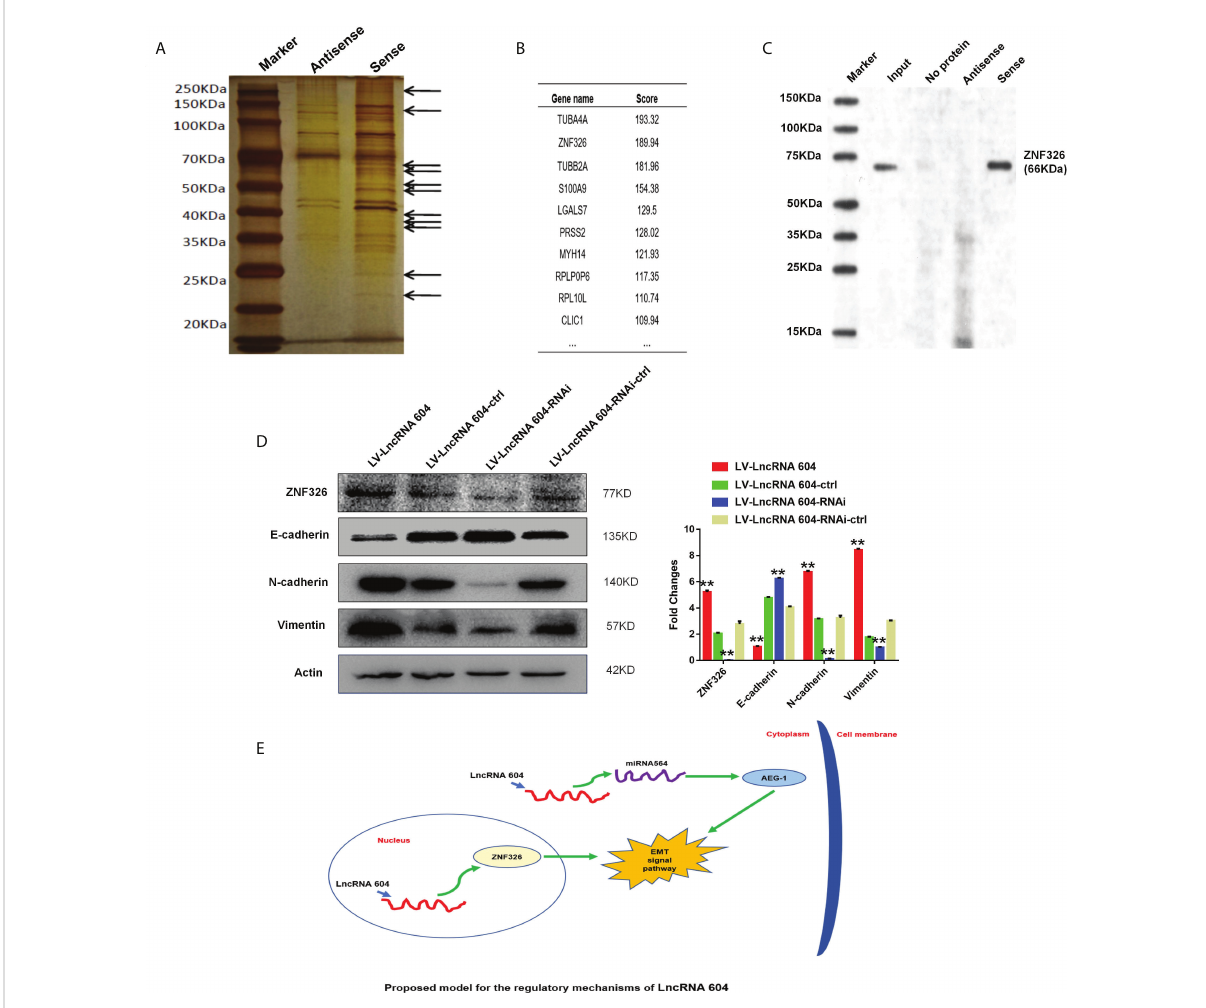
FIGURE 4 The mechanism of lncRNA 604 was detected as binding nuclear transcription factor. (A) The silver staining indicated that all bound proteins were pulled out by RNA pull down assay. (B) ZNF326 was the second most differential protein in lncRNA 604-binding product by mass spectrometry. (C) ZNF326 expression was con fi rmed this speci fi c binding with lncRNA 604 by WB. (D) LncRNA 604 could positively regulate ZNF326, N-cad, Vim expression and decrease E-cad expression. (E) The totle mechanism signal route: lncRNA 604 could inhibit AEG-1 by combining with miRNA564 in the cytoplasm and regulate the nuclear transcription factor ZNF326 in nucleus, which could promote the occurrence of EMT and lead to CRC metastasis. All ** P <